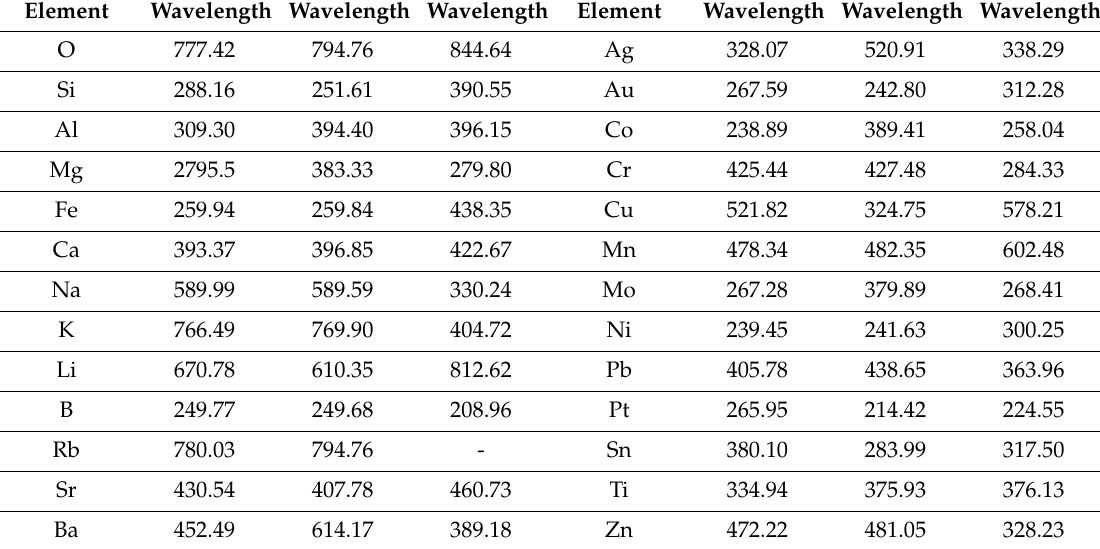
Table 1. Examples of useful spectral emission lines (wavelengths in nm) for elemental identification in common rock-forming minerals (blue columns) and ore deposits (green columns).